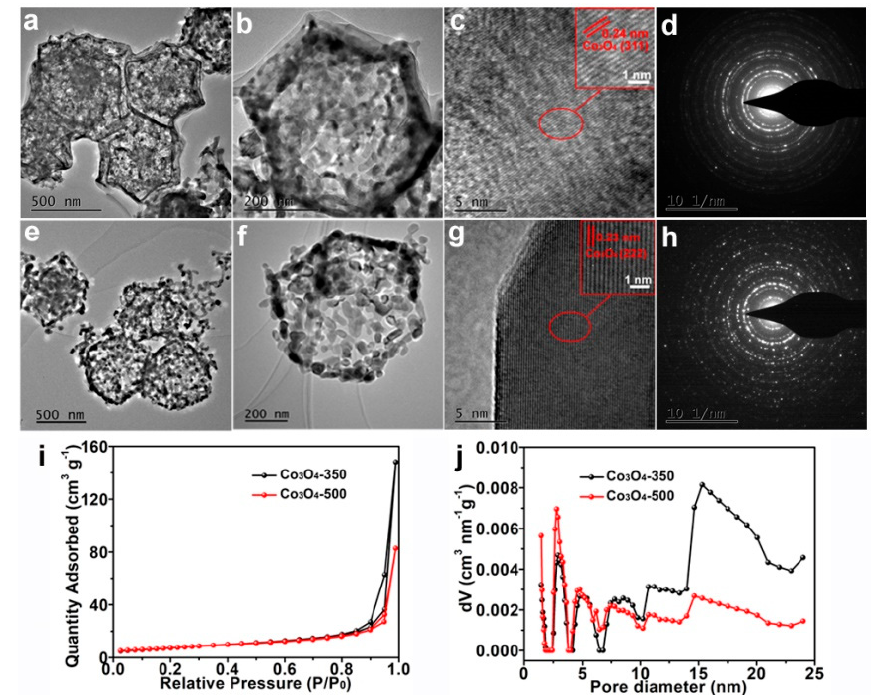
Figure 2. Typical TEM images of both the Co 3 O 4 -350 polyhedrons ( a , b ) and the Co 3 O 4 -500 polyhedrons ( e , f ); The HRTEM images of both the Co 3 O 4 -350 polyhedrons ( c ) and the Co 3 O 4 -500 polyhedrons ( g ); The SAED pattern of both the Co 3 O 4 -350 polyhedrons ( d ) and the Co 3 O 4 -500 polyhedrons ( h ); N 2 absorption–desorption isotherms ( i ) and pore-size distributions ( j ) of the Co 3 O 4 -350 polyhedrons and the Co 3 O 4 -500